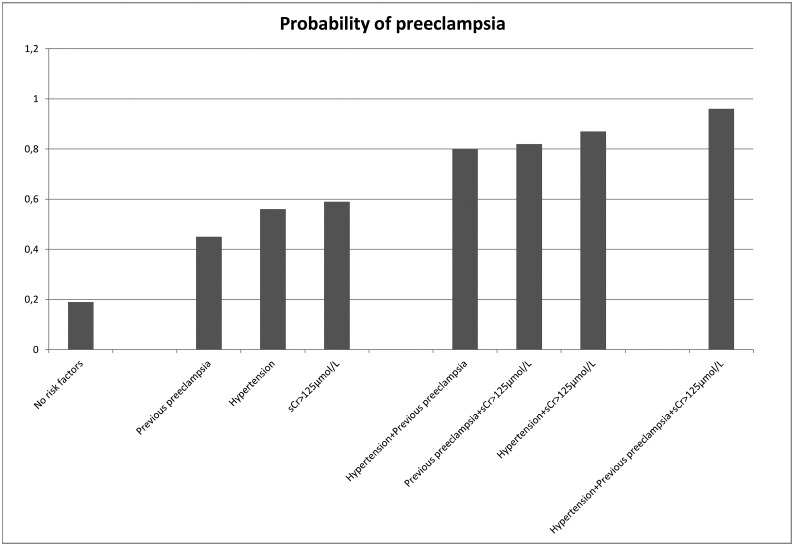
Probability of preeclampsia based on the multivariate model.Estimated probability in percentage according to the presence of different combinations of the prognostic factors.